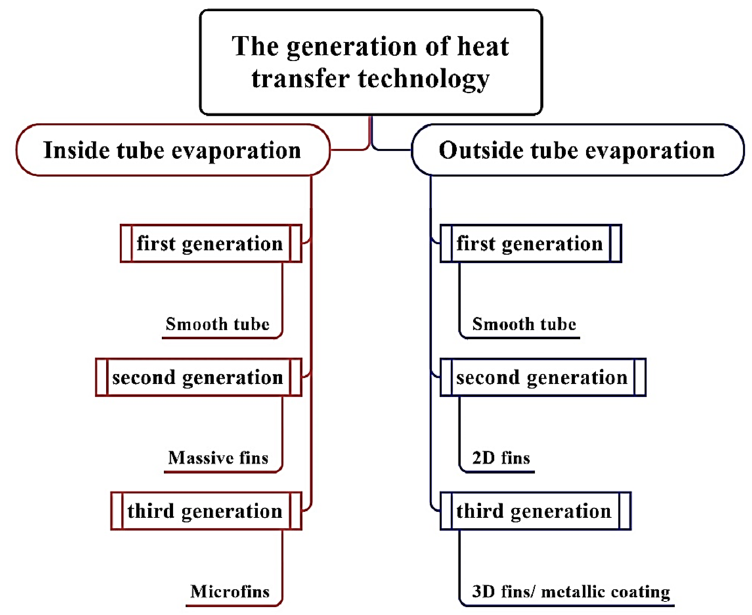
Figure 5. The generation of heat transfer technology.